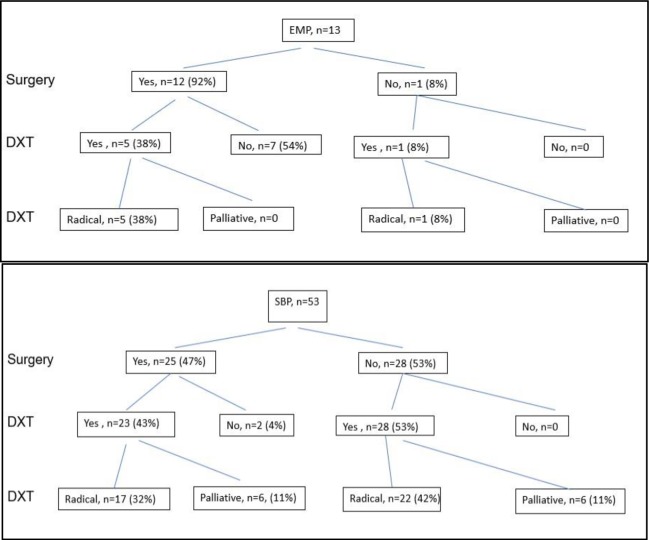
(A) SBP treatment pathways (B) EMP treatment pathways.